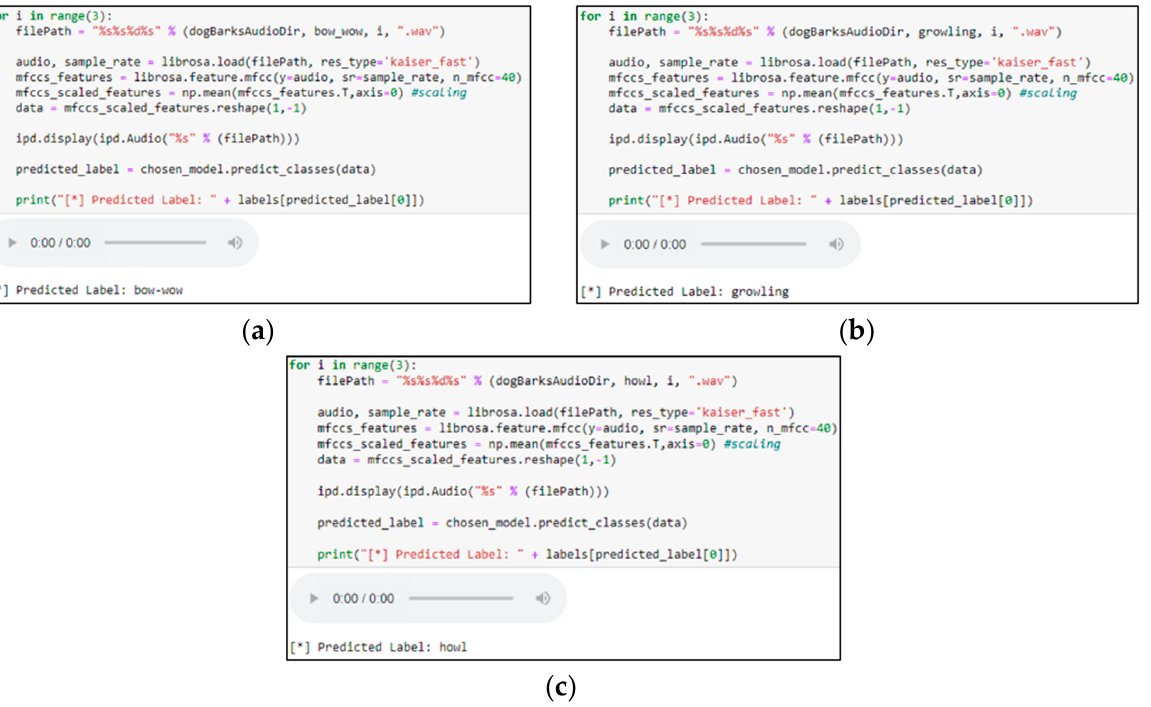
Figure 18. Prediction results of three types of dog barks on the test dataset using a trained model. ( a ) Prediction of bow-wow, ( b ) Prediction of growling and, ( c ) Prediction of Howl.